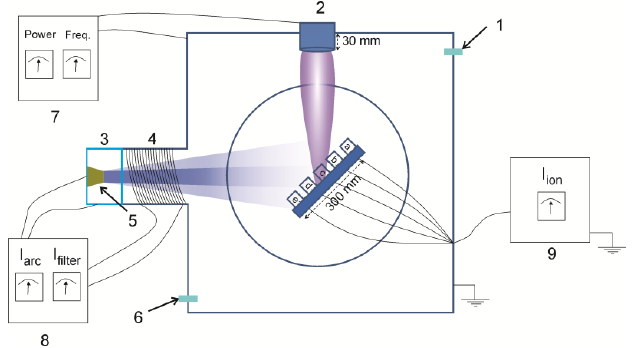
Figure 2. Top view of the chamber presenting location of the substrates (1—vacuum cryo pump inlet, 2—3’’ MoS 2 sputtering target, 3—anode, 4—linear filter, 5—Ti cathode, 6—argon inlet,